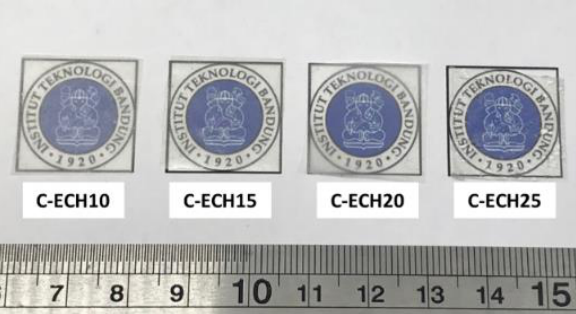
Figure 2. Cellulose bioplastic samples at various ECH concentrations.